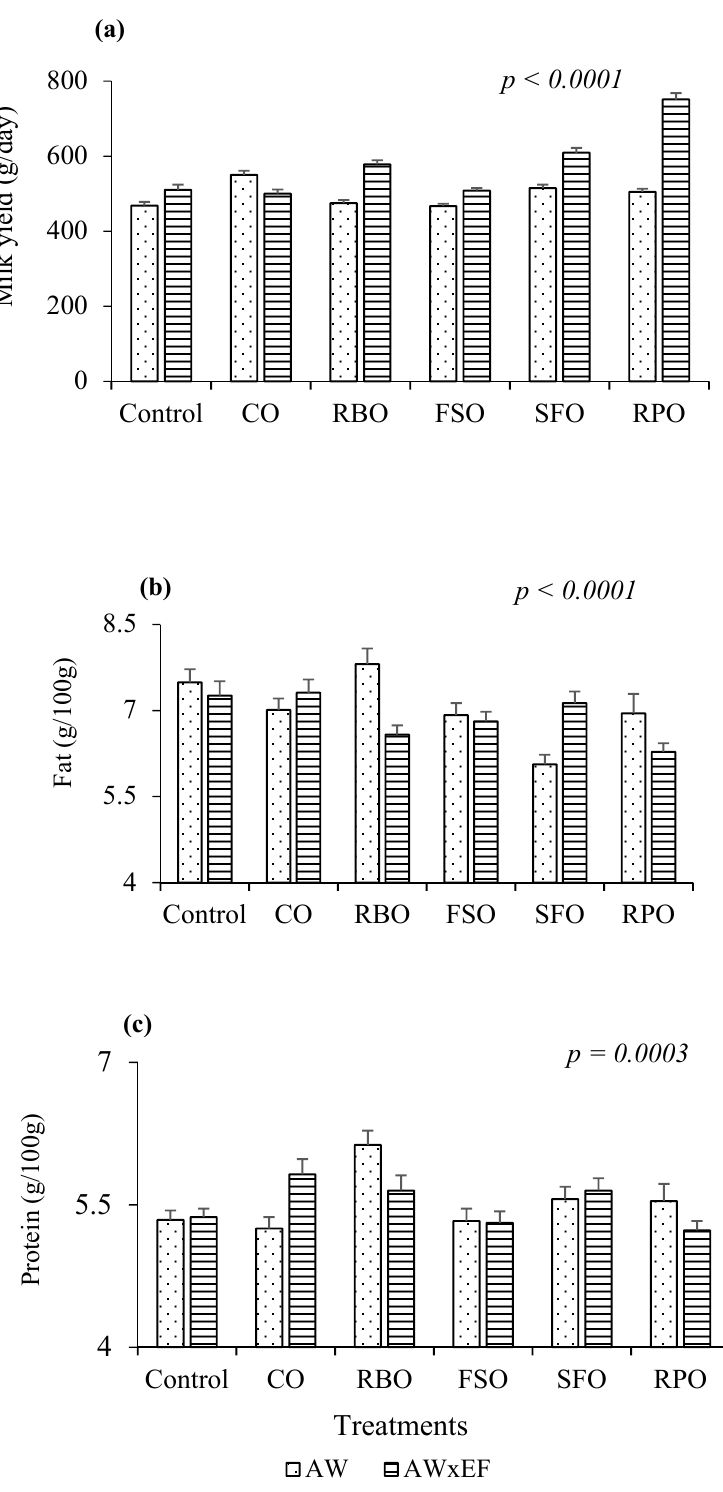
Figure 3. Supplementary diet and breed interactions on ( a ) milk yield; ( b ) milk fat; and ( c ) milk protein. Canola oil (CO), rice bran oil (RBO), flaxseed oil (FSO), safflower oil (SFO), rumen-protected oil (RPO).